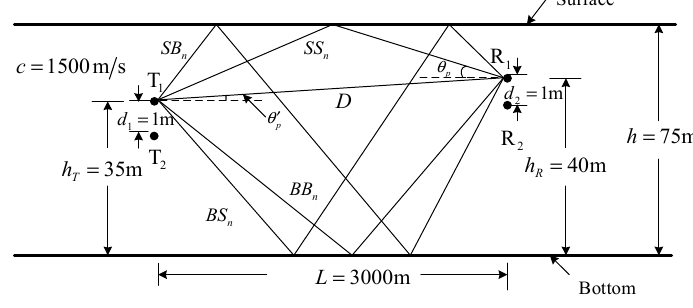
Figure 5. Simulation channel setup .